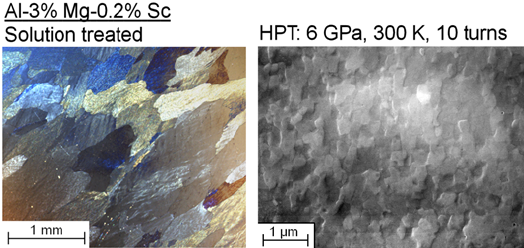
Figure 1. Grain structure of the Al-3% Mg-0.2% Sc alloy (a) after solution treatment at 880 K for 1 h (optical microscopy) and (b) after processing through 10 turns of HPT at room temperature (SEM).